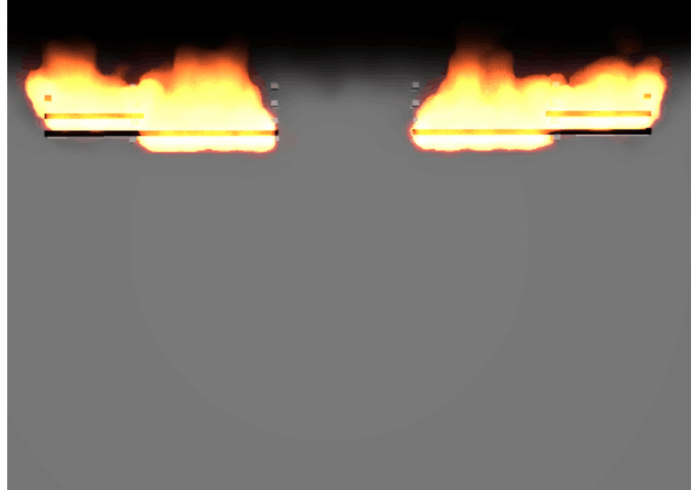
Figure 7. Simulation of cable combustion at 1380